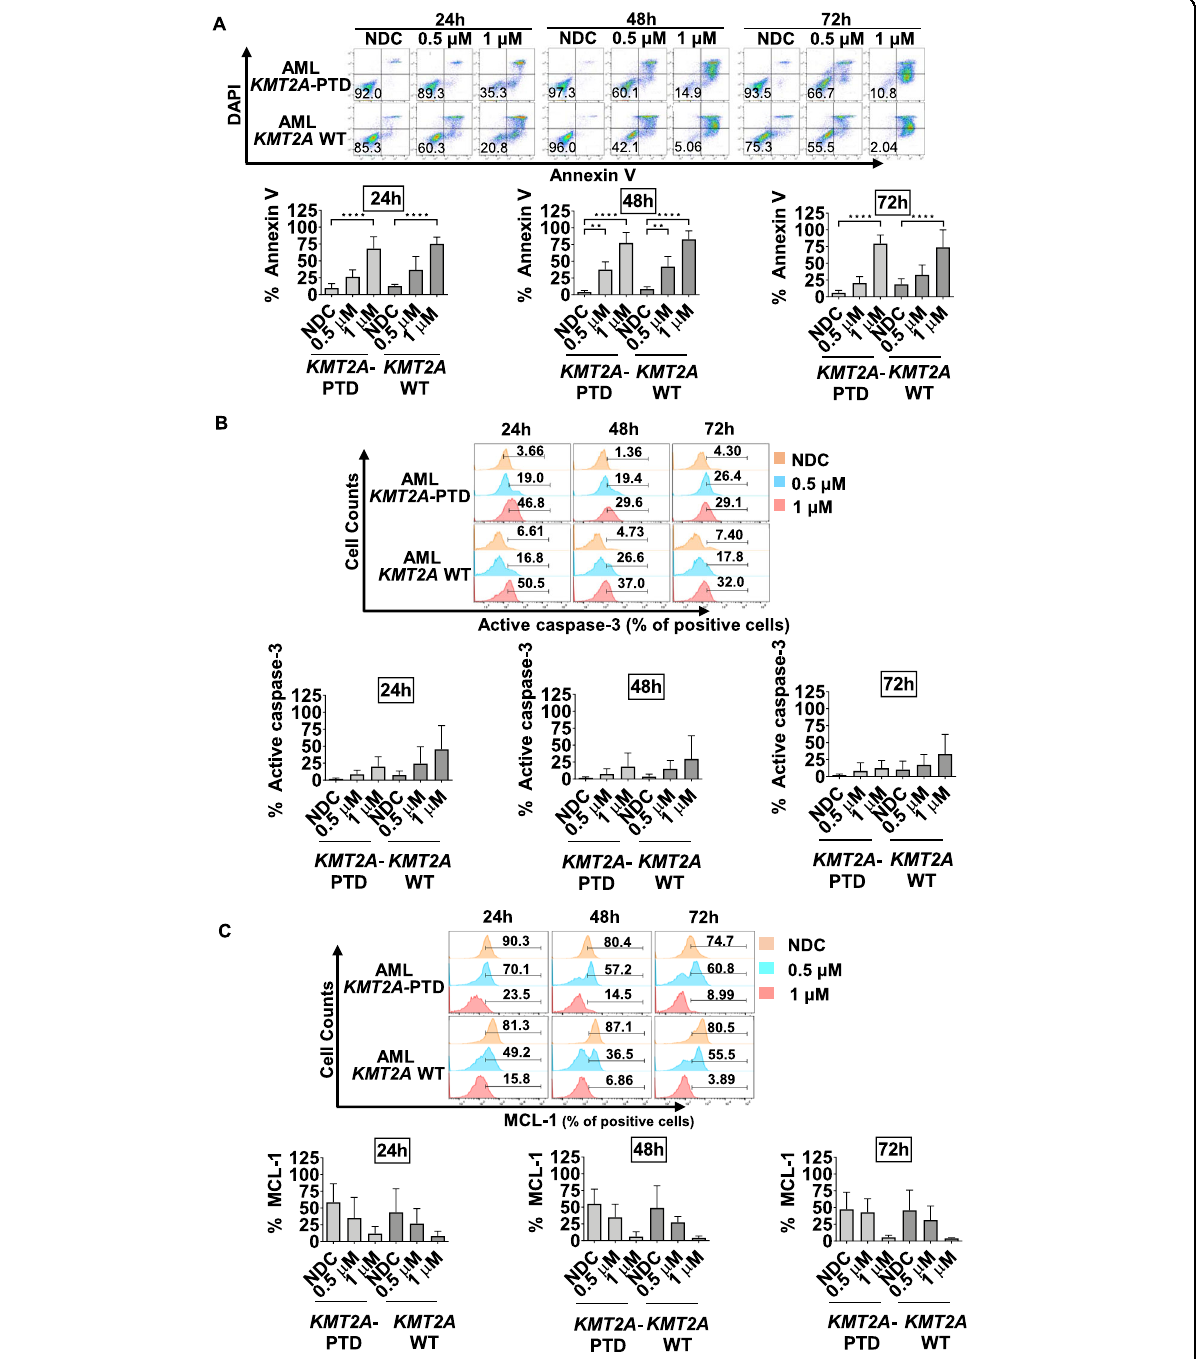
Fig. 3 Fadraciclib induces apoptosis and decreased MCL-1 expression in primary AML cells, regardless of KMT2A -PTD status. All samples were treated with 0.5 µM or 1 µM of fadraciclib for 24 h, then the drug was washed out and cells were cultured in fresh media for up to 72 h. A Representative fl ow cytometry plots and summary bar charts of the percentage of annexin V-positive cells. n = 4 – 5. B Representative fl ow cytometry plots and summary bar charts of the percentage of active caspase-3-positive cells. n = 4 – 5. C Representative fl ow cytometry plots and summary bar charts of the percentage of the MCL-1 level. n = 3. Graphs depict mean ± SD (** p < 0.01, **** p < 0.0001). Data were compared using